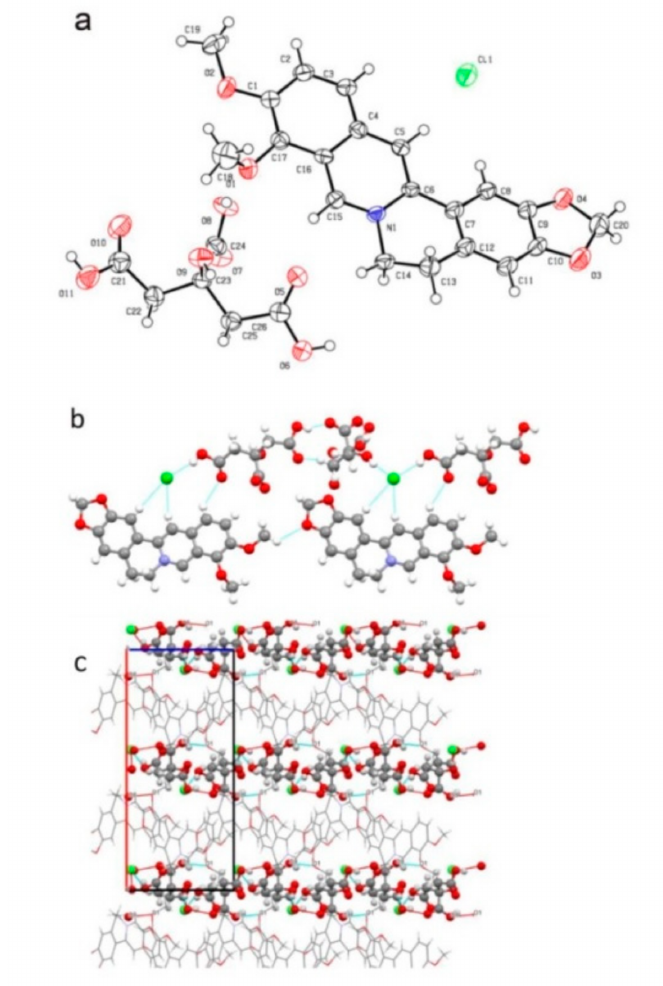
Figure 13. The crystal structures of BCl–CA cocrystal: ( a ) thermal ellipsoid drawing including atomic labelling scheme, ( b ) key intermolecular interactions (hydrogen bonds are teal colored), ( c ) molecular packing [60] (with permission from [60]; Copyright 2019